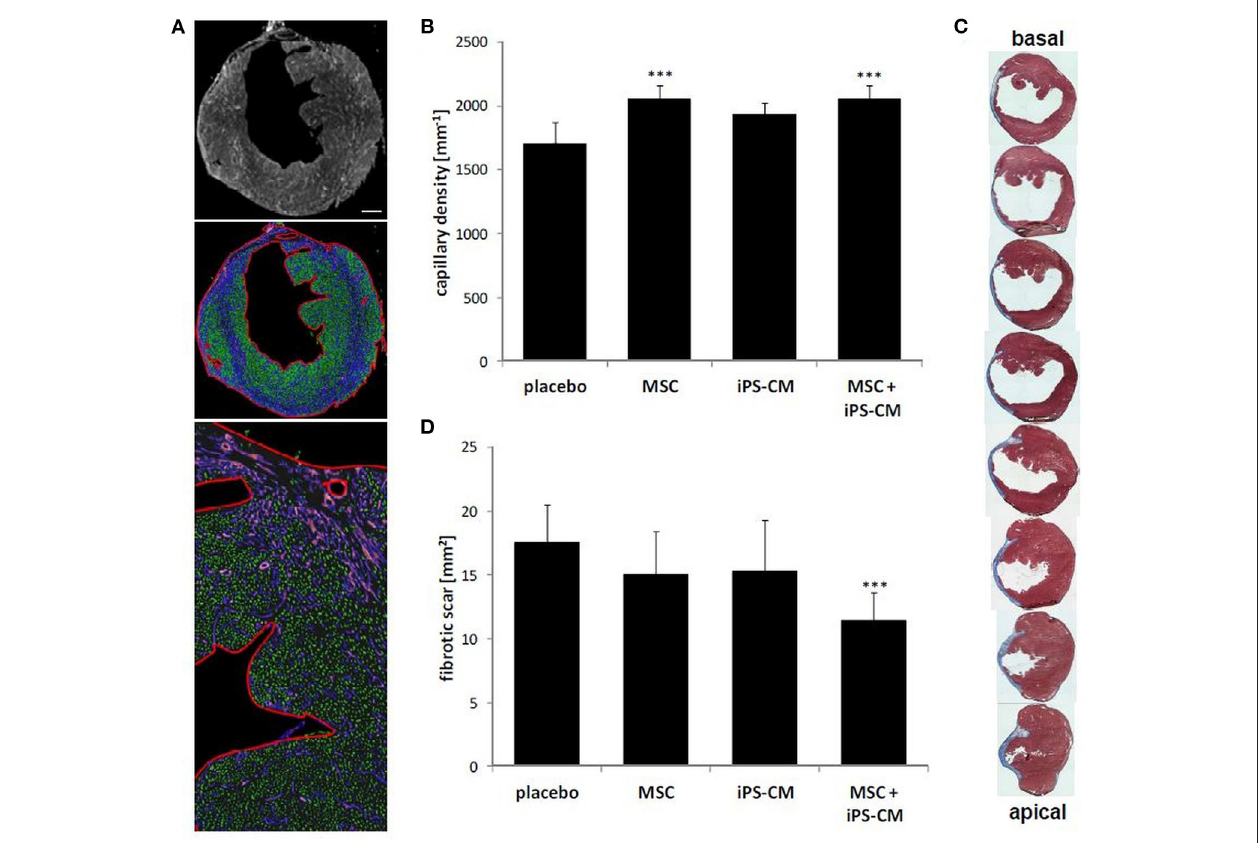
FIGURE 6 | Assessment of scar area and capillary density in hearts 4 weeks after MI and cell transplantation. (A) Immunohistological staining of transversal heart sections for the endothelial-specific marker caveolin-1 (white in the top panel; violet in middle and lower panels). Capillary density was determined by image analysis software (Nikon Elements NIS) according to the size and circularity of fluorescents objects (marked in green in middle and lower panel) within defined regions of the myocardium (outlined in red in the middle and lower panel). Scale bar: 500 µ m. (B) Quantitative analysis of capillary density 4 weeks after cell transplantation in each experimental group. *** p < 0.001 vs. placebo. (C) Serial Masson’s Trichrome stained sections (blue: fibrotic area) of hearts 4 weeks after induction of MI from basal to apical infarction border. Gaps between displayed sections are 100 µ m. (D) Quantitative analysis of infarction scar expansion based on Masson’s Trichrome stained sections in indicated experimental groups. *** p < 0.001 vs. placebo (all one-way ANOVA with the Tukey-Kramer post-hoc